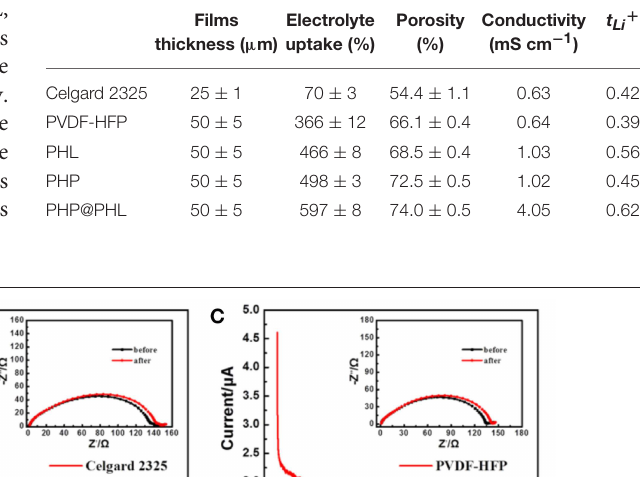
TABLE 1 | The film thickness, electrolyte uptake, porosity, effective ionic conductivity, and lithium ion transference number of Celgard 2325, PVDF-HFP, PHL, PHP, and PHP@PHL separators.